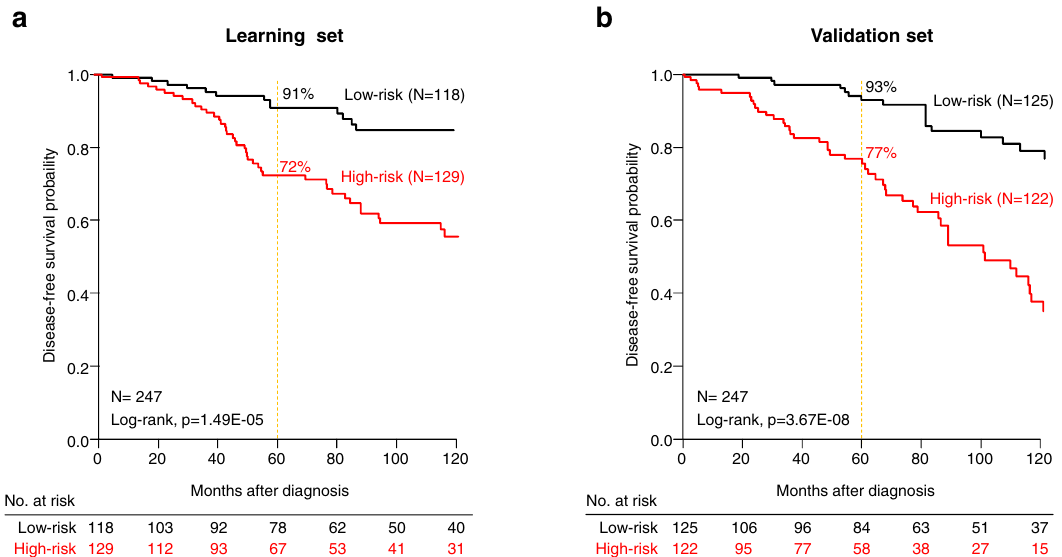
Fig. 3 Disease-free survival in Luminal B early breast cancer patients only treated with adjuvant endocrine therapy without adjuvant chemotherapy according to a clinico-genomic model combining CINSARC, pathological tumor size and lymph node status. a Kaplan – Meier disease-free survival (DFS) in Luminal B breast cancer patients according to the two classes de fi ned by the model (high-risk versus low-risk) in the learning set. b Similar to a , but in the validation set.